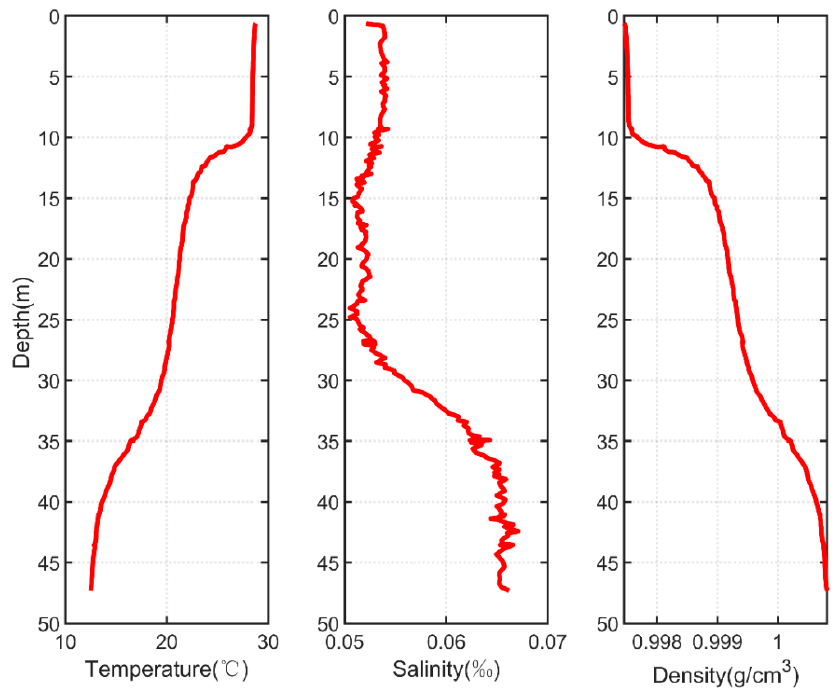
Figure 11. Depth profiles of temperature, salinity and density in Qiandao Lake.